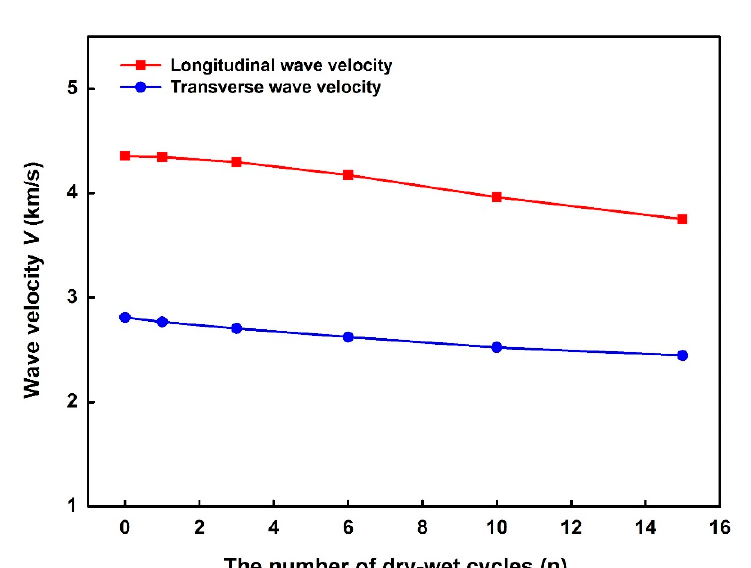
Figure 9. The relationship between the average acoustic velocity in the rocks and the number of dry-wet cycles.